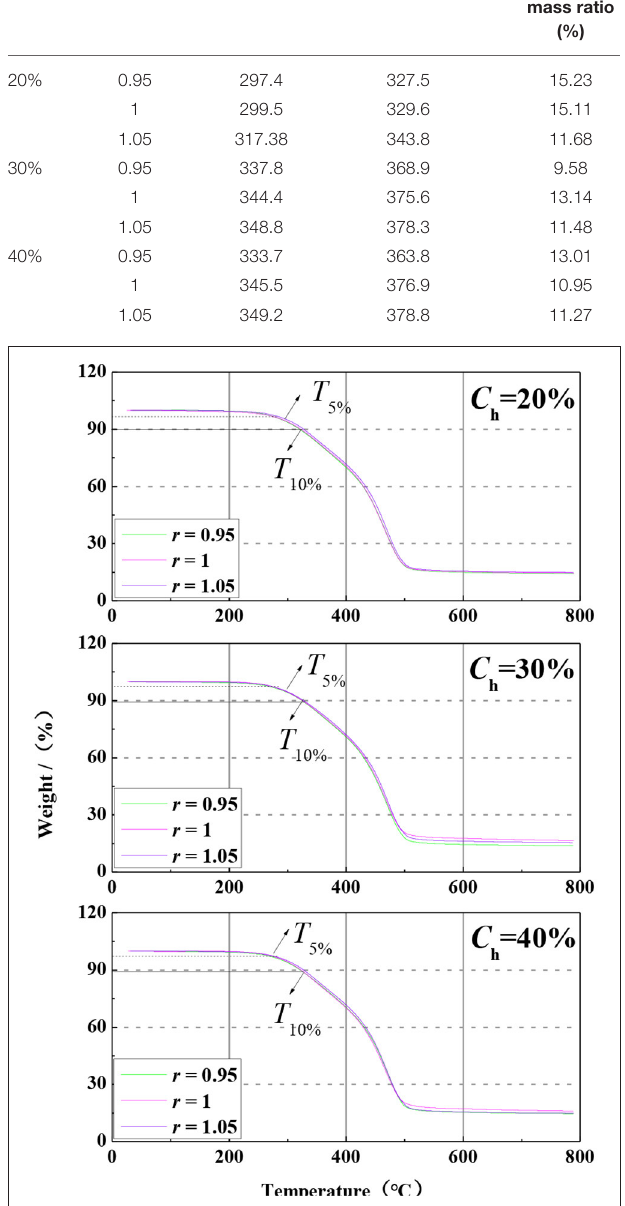
FIGURE 25 | TG curves of polyether-based TPU-modified asphalt.